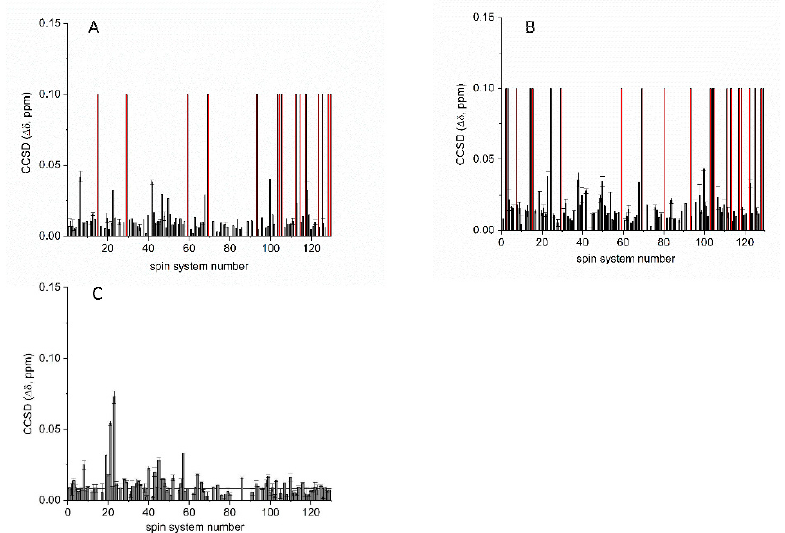
Figure 5. Overlay between 1 H- 13 C ALSOFAST-HMQC spectra acquired at 1200 MHz on batch 20G and sample incubated with 1% of H 2 O 2 ( A ); and between 1 H- 13 C methyl correlation spectra acquired at 1200 MHz on batch 20G and sample incubated at pH 10 for 48 h ( B ). Bar plots of the Euclidean distances of batch 20G and 20G NMR spectra acquired at 1200 MHz ( C ); the distances were calculated between the spectra of 19G, 20G nontreated and 33G treated with H 2 O 2 for 24 and 48 h (green and red bars, respectively) and 33G treated at pH 10 (yellow bar). PCA score plot of 1 H- 13 C methyl correlation spectra acquired at 1200 MHz ( D ). References batches 19G and 20G (cyan dots), mAbs samples incubated with 1% of H 2 O 2 for 24 h (green dots); for 48 h (red dots) and incubated at pH 10 for 48 h (yellow dots).